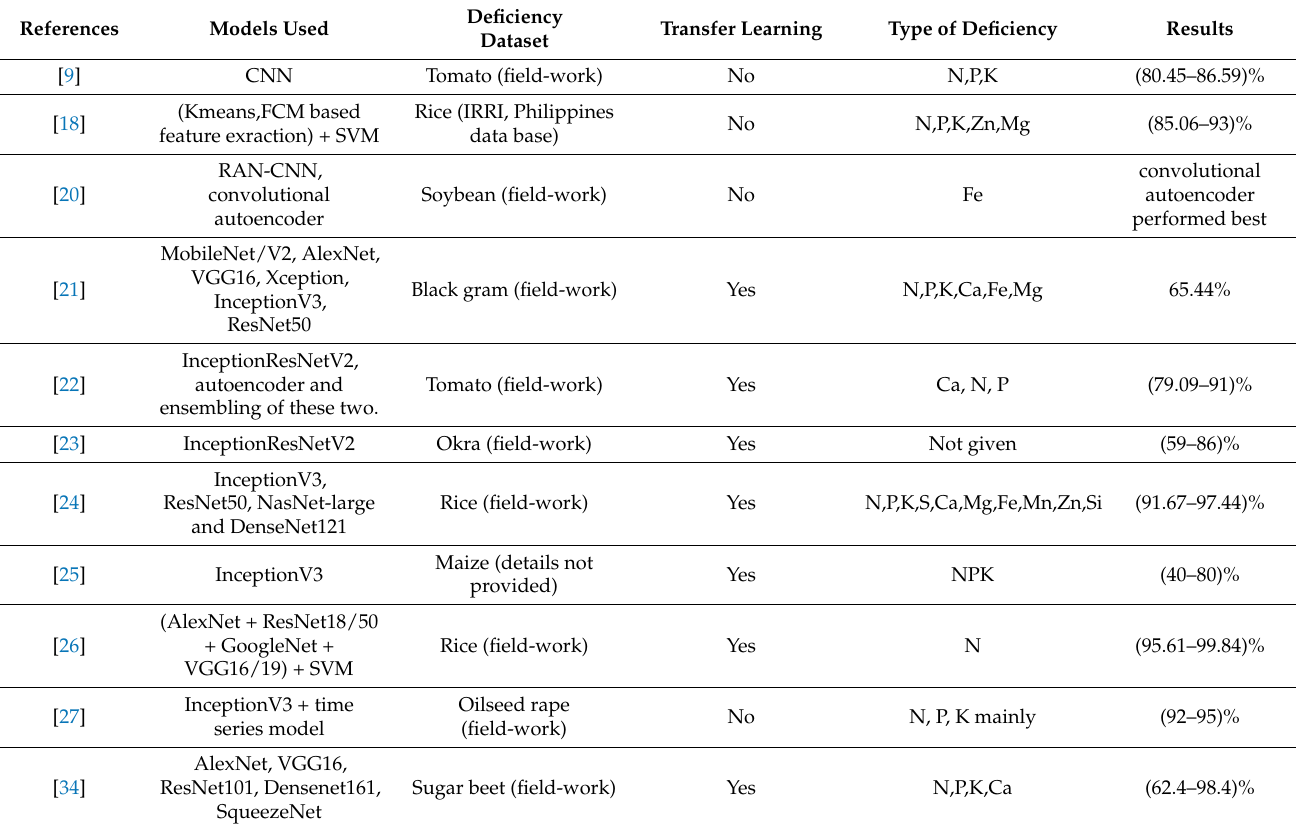
Table 1. CNN studies on rice deficiency classification.